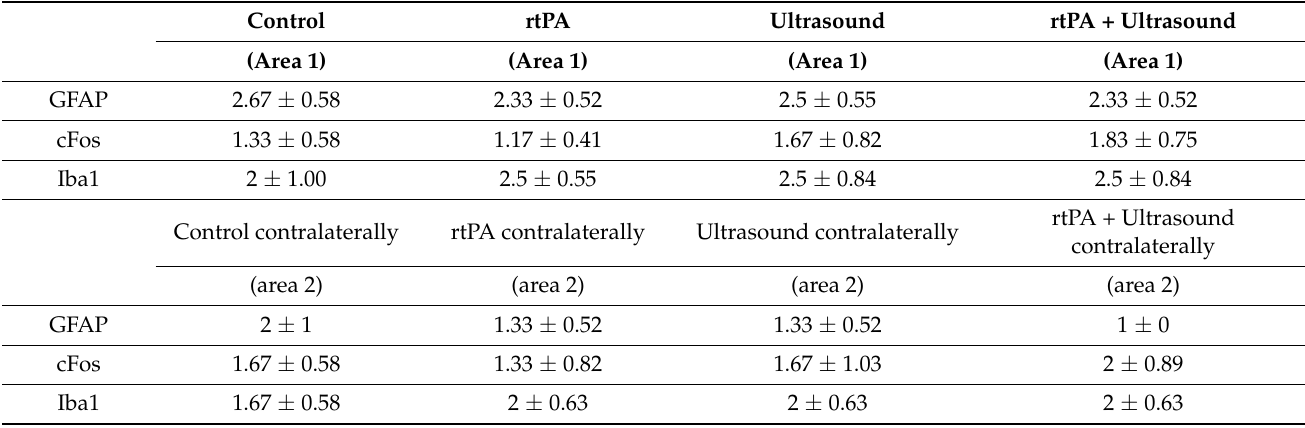
Table 1. Score of immunohistochemistry perihematomal (area 1) and contralaterally (area 2) to the ICH (control Group n = 3; treatment groups (2–4); each n = 6).